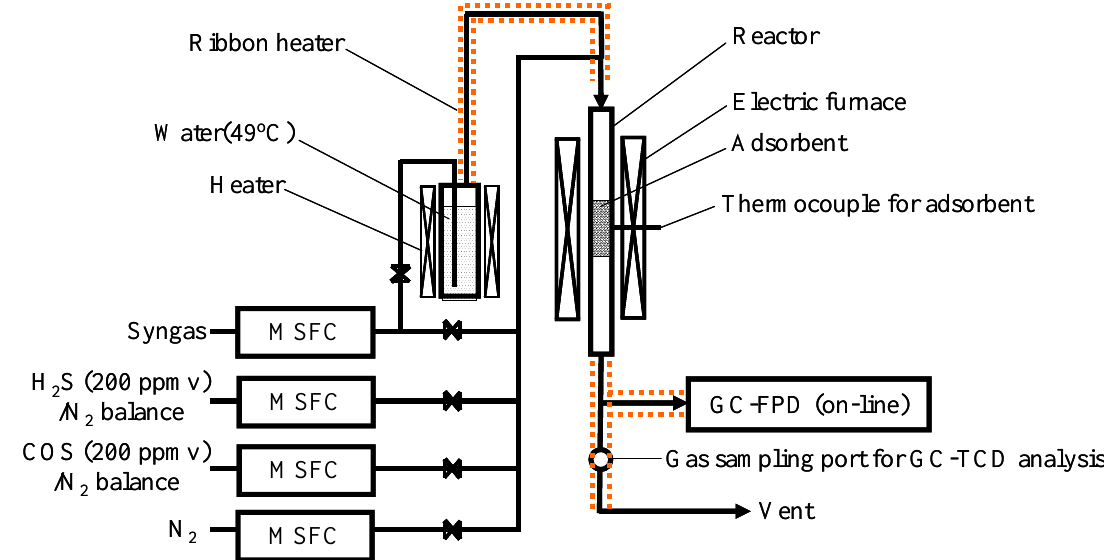
S and COS capture. 2